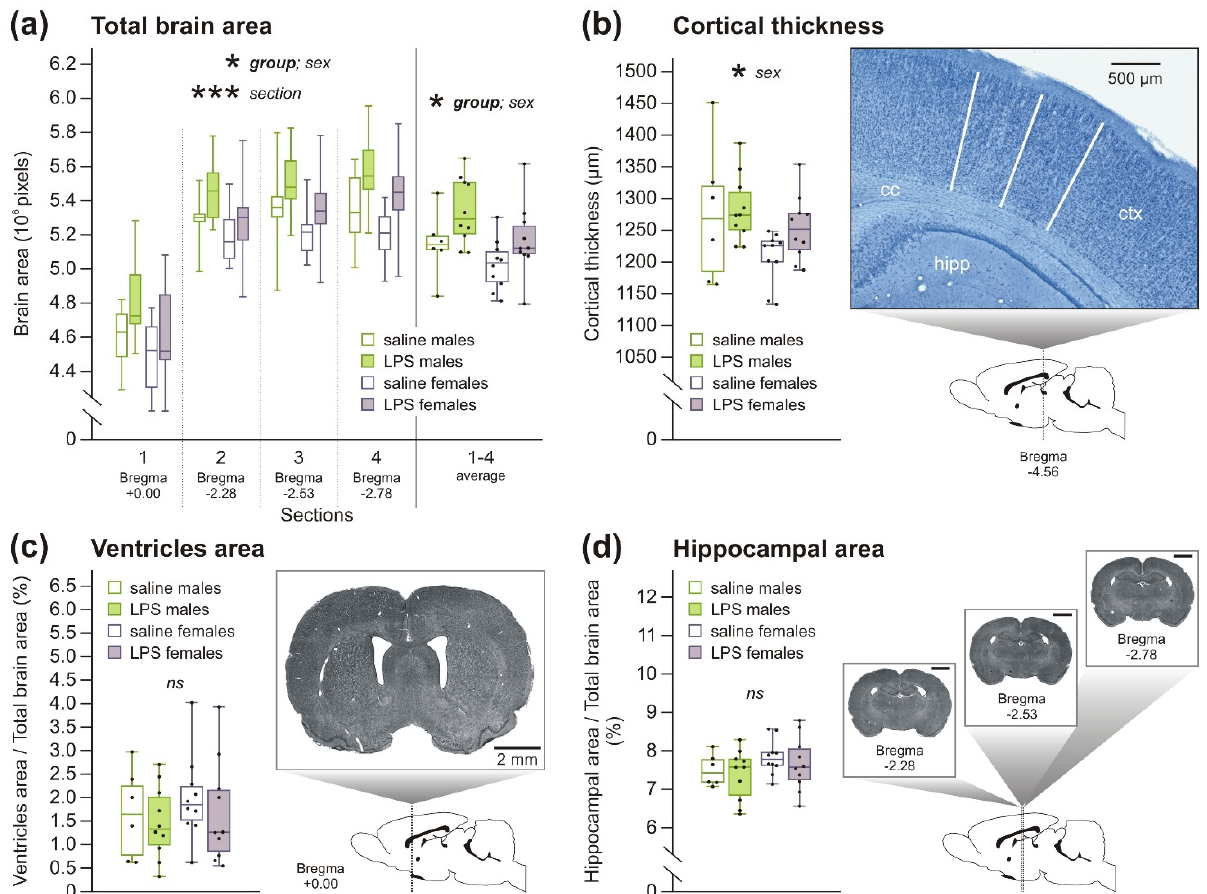
Figure 1. Brain morphology in P28-old rats. ( a ) Areas of four different brain sections were larger in both males and females of lipopolysaccharide (LPS)-treated dams compared to controls, as three-way analysis of variance with repeated measures (3wANOVA-RM) confirmed. In addition, males had larger brain area than females. ( b ) Cortical thickness in the LPS-exposed offspring was not significantly different from the control offspring, as it was shown by the two-way ANOVA (2wANOVA), but there was the sex effect, as males had thicker cortex than females. ( c , d ) Ventricles area ( c ) and dorsal hippocampal area ( d ) shown as a percentage of whole brain area, both analyzed by 2wANOVA, were not significantly affected by prenatal exposure to LPS. Scale bars show 2 mm. In the graphs in panels ( b – d ), each boxplot shows an average value for the left and right hemispheres. The boxplots show median, first and third quartile and minimum and maximum values; the dots show individual values. * p < 0.05, *** p < 0.001, ns = no significance. cc = corpus callosum; ctx = cortex; hipp = hippocampus.